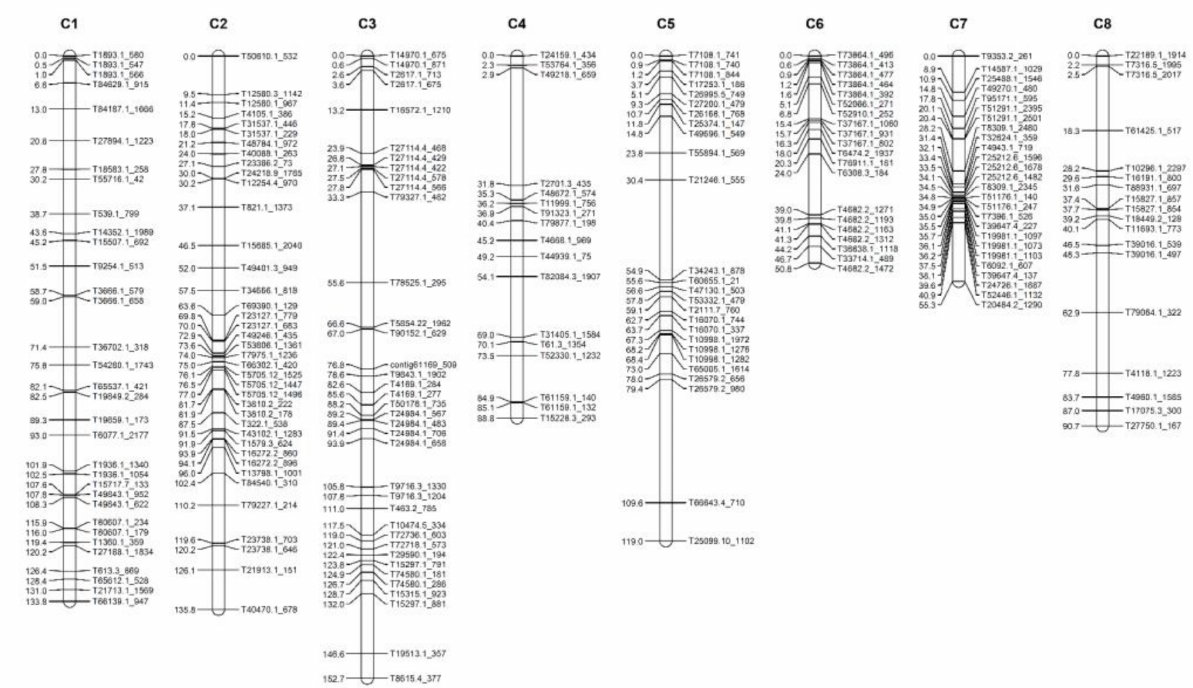
Figure 2. Genetic map of onion constructed by GBS-based SNP markers. Number on the left side corresponds to the genetic distance in cM from the top of each chromosome. Names on the right side indicate marker